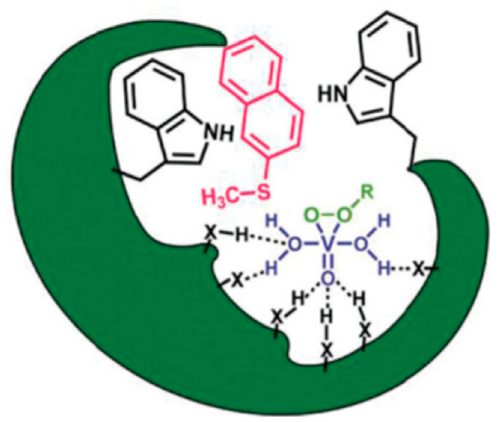
Figure 11. Vanadium-dependent artificial peroxidase for enantioselective sulfoxidation reactions. Reprinted with permission from (Dong et al., 2012) [13]. Copyright 2012 Royal Society of Chemistry.